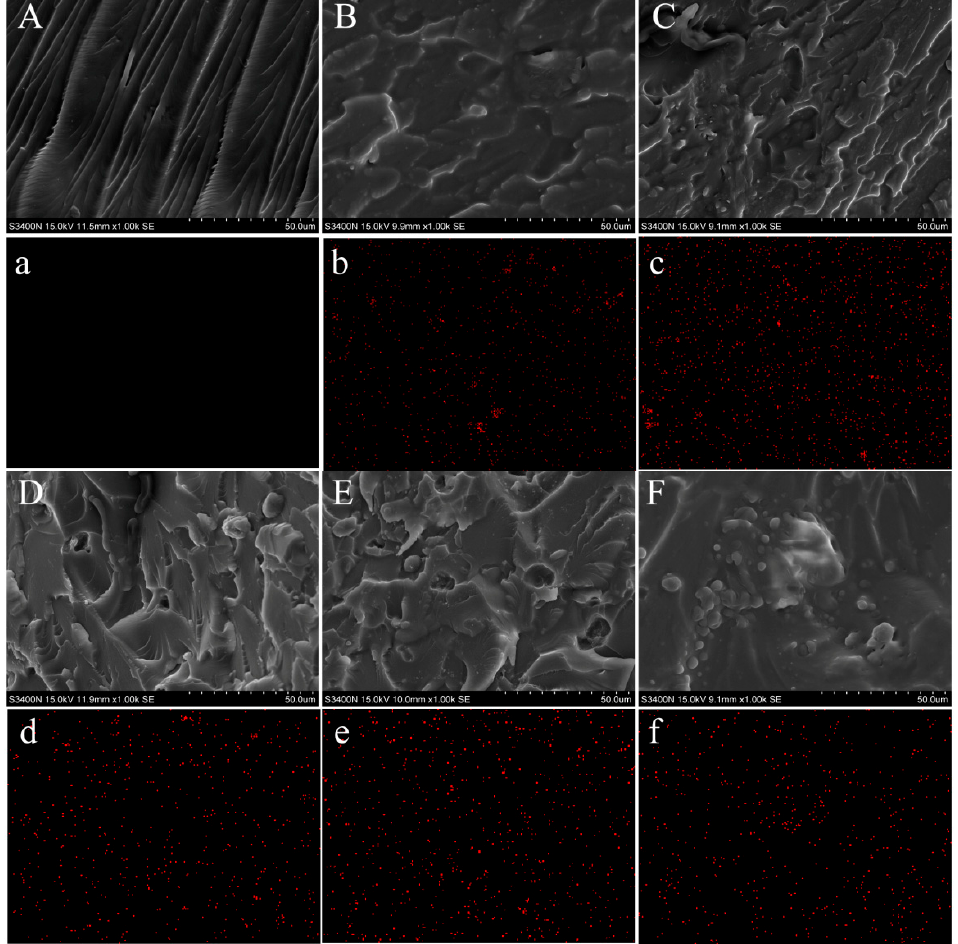
Figure 4. SEM images ( A – F ) and titanium element mapping images ( a – f ) for the fractured surfaces of PMMA composite resins after flexural testing: Control ( A - a ); Group 1 ( B - b ); Group 2 ( C - c ); Group 3( D - d ); Group 4 ( E - e ); and Group 5( F - f ).